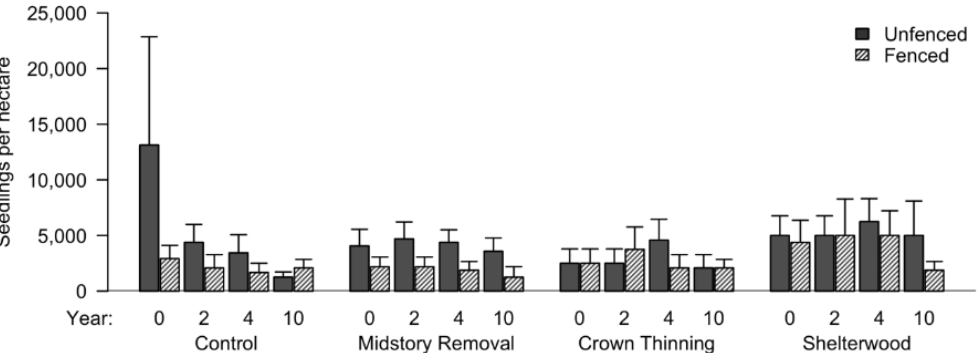
Figure 4. Mean (+SE) density of oak ( Quercus spp.) seedlings per hectare in response to silvicultural treatments and deer fencing. Year 0 represents pretreatment data.